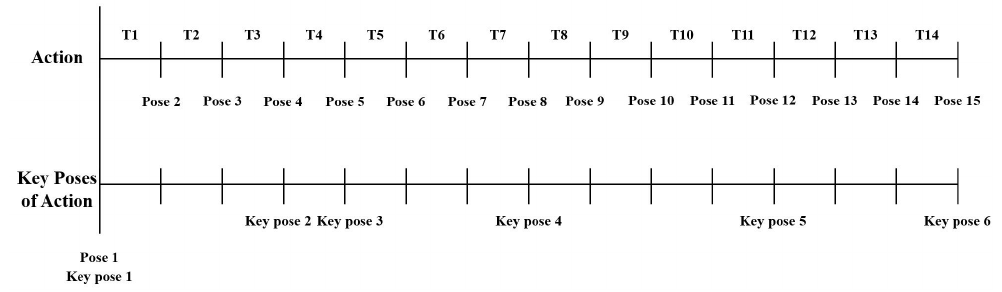
Figure 5. Relation of poses and key